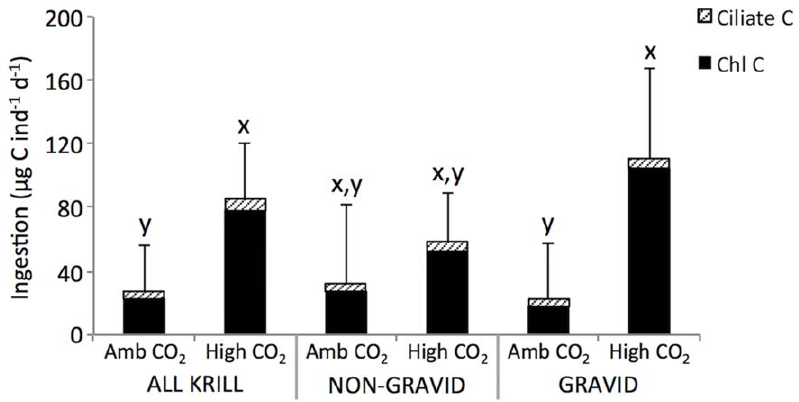
Figure 1. Euphausiasuperba ingestion rates. Chlorophyll a and ciliate carbon ingestion rates of krill exposed to ambient (Amb) and high ( (cid:2) xx =672 ppm) concentrations of CO 2 . Chlorophyll a was converted to C using a C:chl ratio of 63:1 estimated in our study area by Bernard et al. [74]. Ingestion rates of krill on ciliates were converted to C using cell C to volume conversions from Putt and Stoecker [76]. Mean of n=5 for non-gravid and gravid krill and n=10 for all krill; error bars=2 6 standard error. x and y denote a significant difference in total C ingestion rates between treatments (x . y, p , 0.05). doi:10.1371/journal.pone.0052224.g001 PLOS ONE |